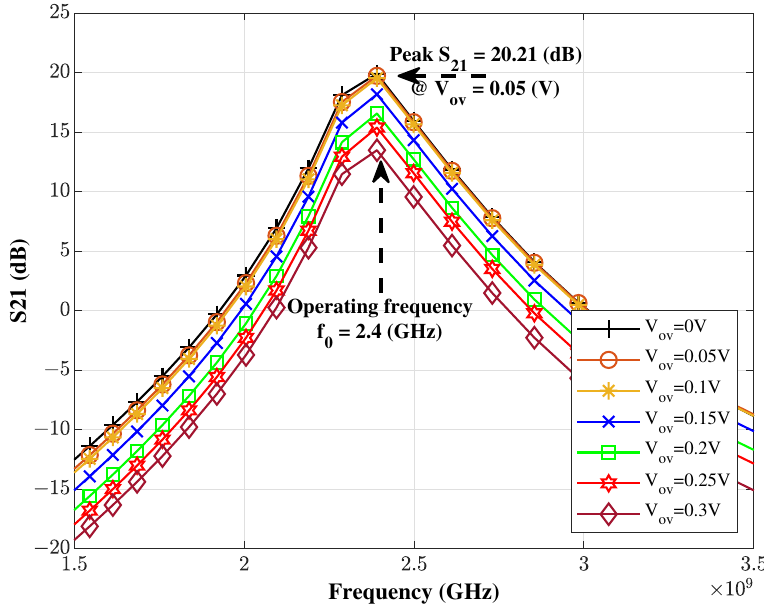
Figure 4. S 21 vs.